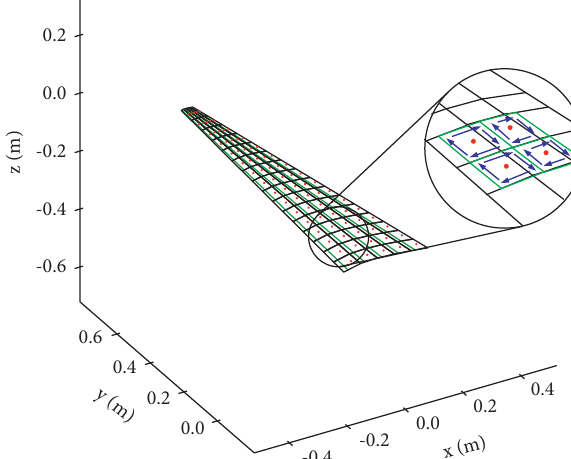
Figure 5: Vortex arrangement on the wing model.